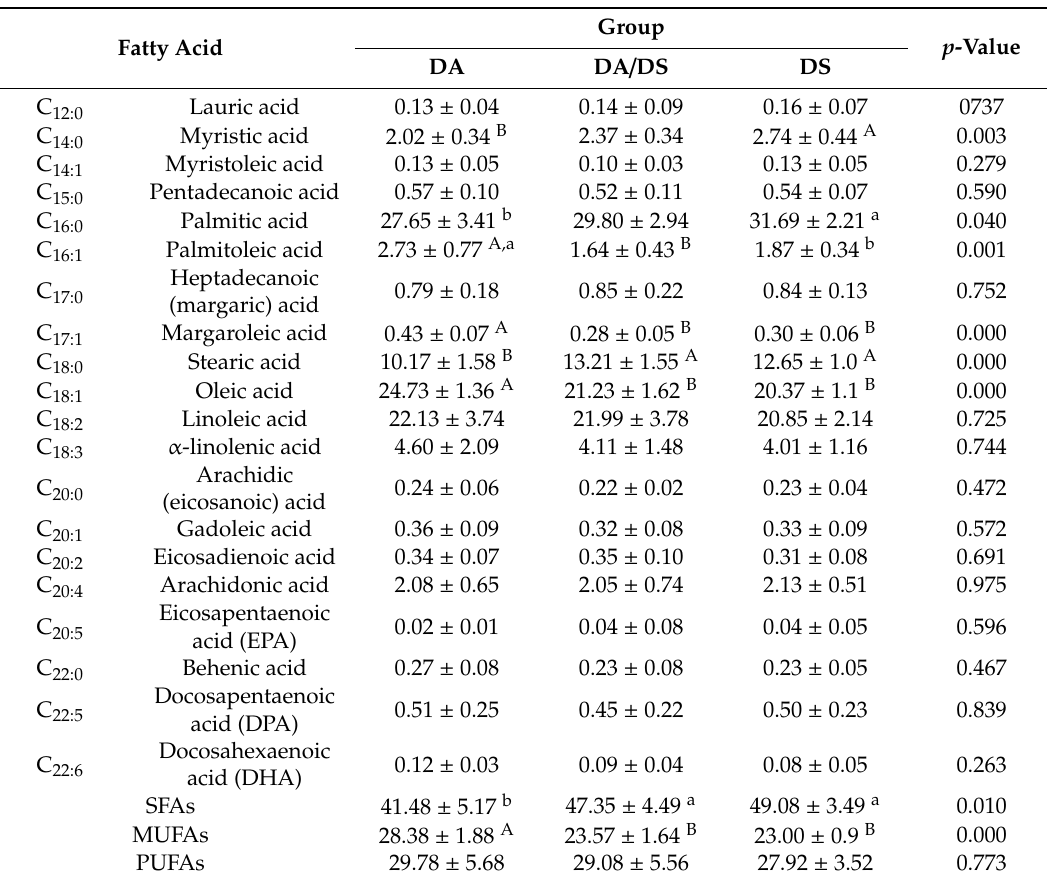
Table 8. Fatty acid profiles in the hind leg muscles of rabbits (% total fatty acid pool; mean ± SD; n =